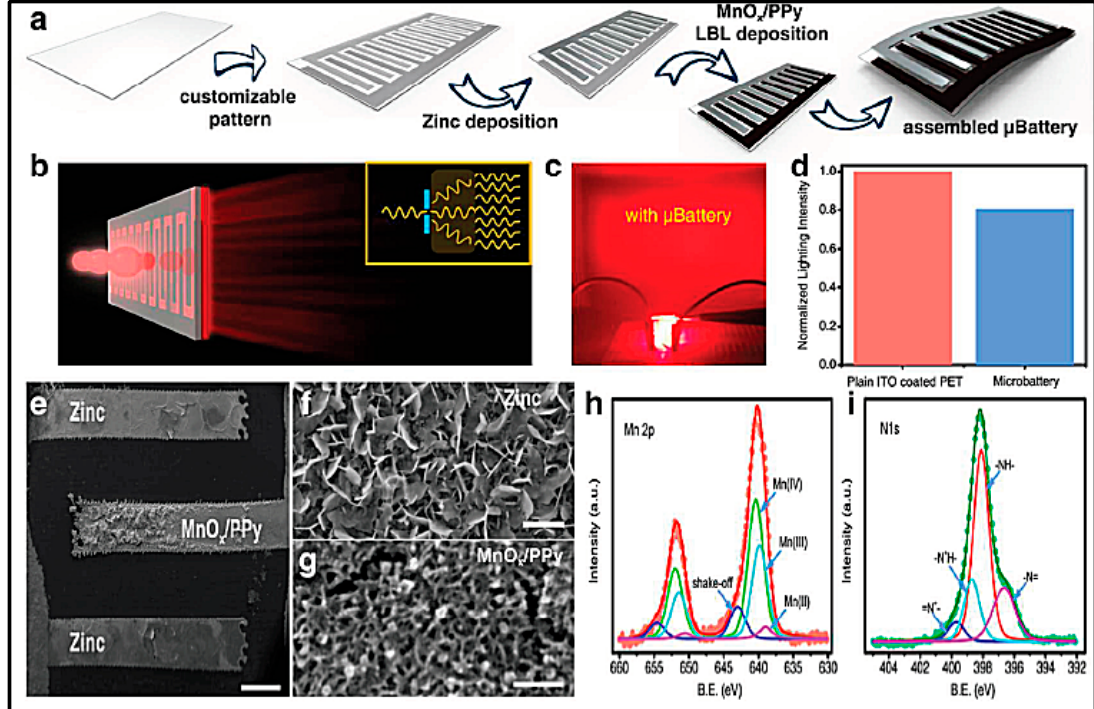
Figure 19. Fabrication and characterizations of the microbattery. ( a ) Schematic illustration of the fabrication process for the microbattery. ( b ) Schematic illustration of the light permeability and hazing effect of the microbattery. ( c ) The digital photograph with a red LEDs as the backlight, showing good light permeability and hazing ability. ( d ) Light intensity after permeating the microbattery, normalized to the light intensity after permeating the plain ITO coated PET. ( e ) SEM image of the interdigitated micro-electrodes (scale bar: 500 µm), ( f ) SEM images of the electrodeposited zinc anode. ( g ) SEM images of the electrodeposited MnOx/PPy cathode (scale bar: 500 nm). ( h ) Mn 2p core spectrum and ( i ) N 1s core spectrum of PPy measured by XPS. Reproduced with permission from [317]. Copyright 2018 Royal Society of Chemistry.